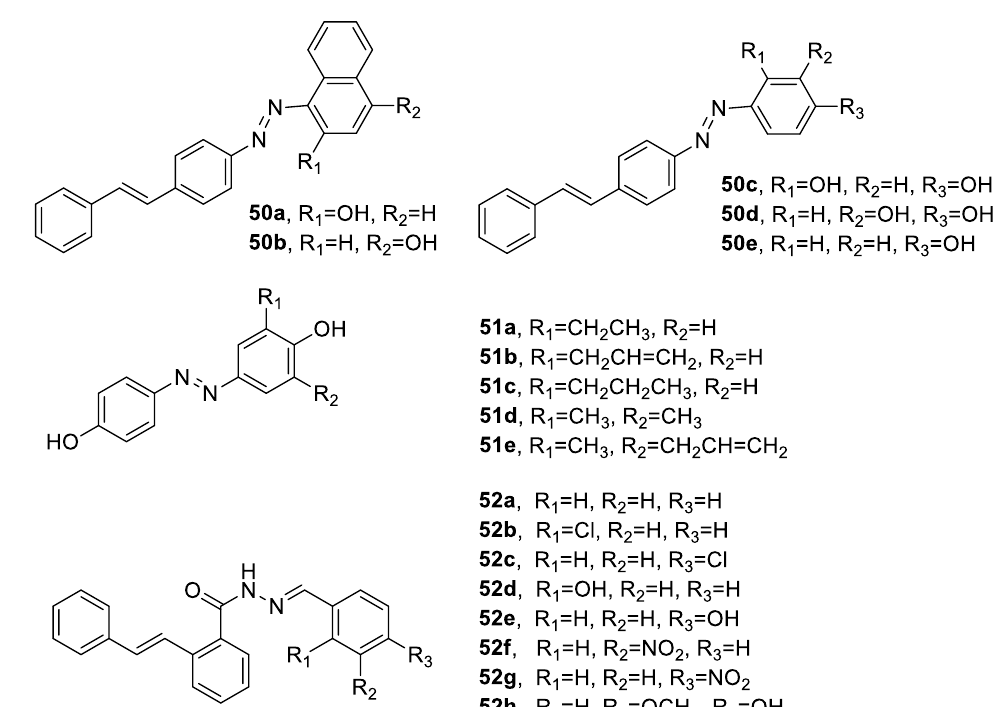
Figure 13. Nitrogen-containing stilbenes tested against Gram-negative and Gram-positive bacteria from Rezaei-Seresht et al. (2018) [88] and from Iqbal et al. (2018) [89].